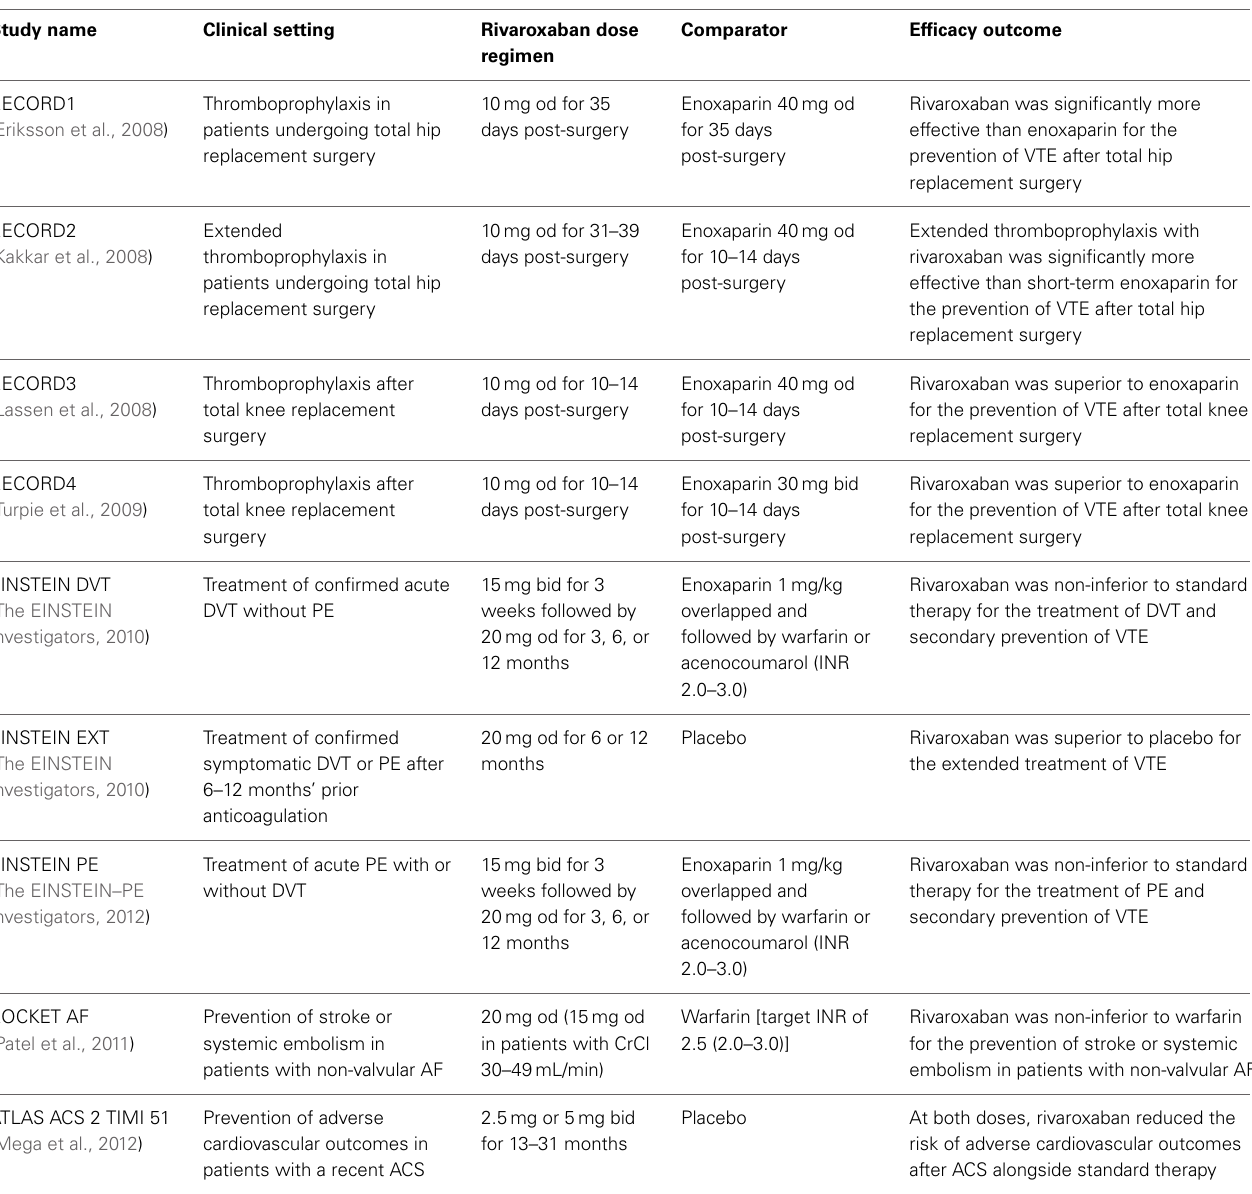
Table 2 | Clinical evaluation of rivaroxaban in phase III